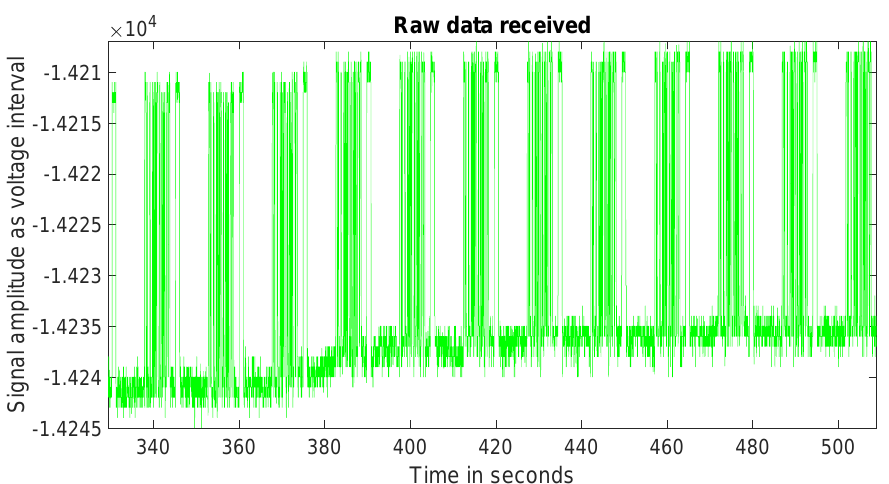
Figure 9. Sample of received signal during showing multiple data packets.